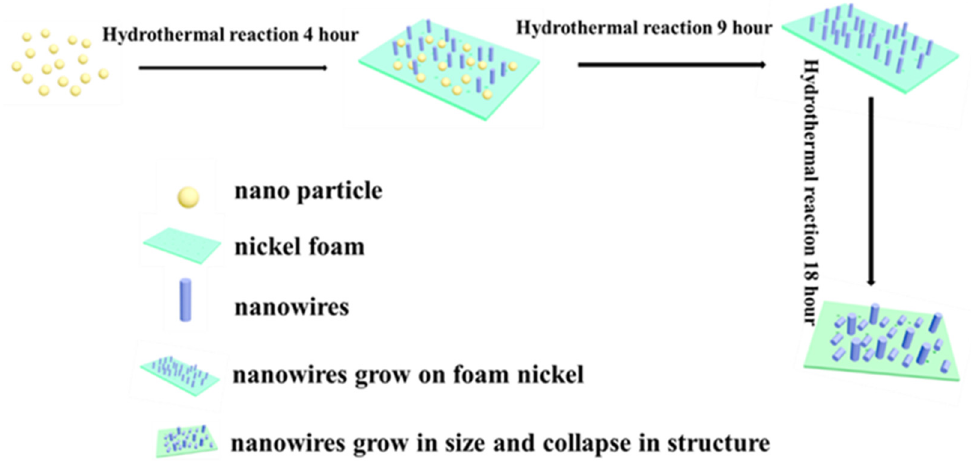
Figure 4. Schematic illustration for the fabrication process of WO 3 nanowires.